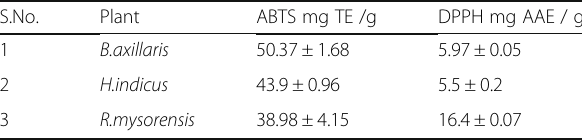
Table 4 Free radical scavenging activity of CHCl 3 fractions using ABTS and DPPH assays